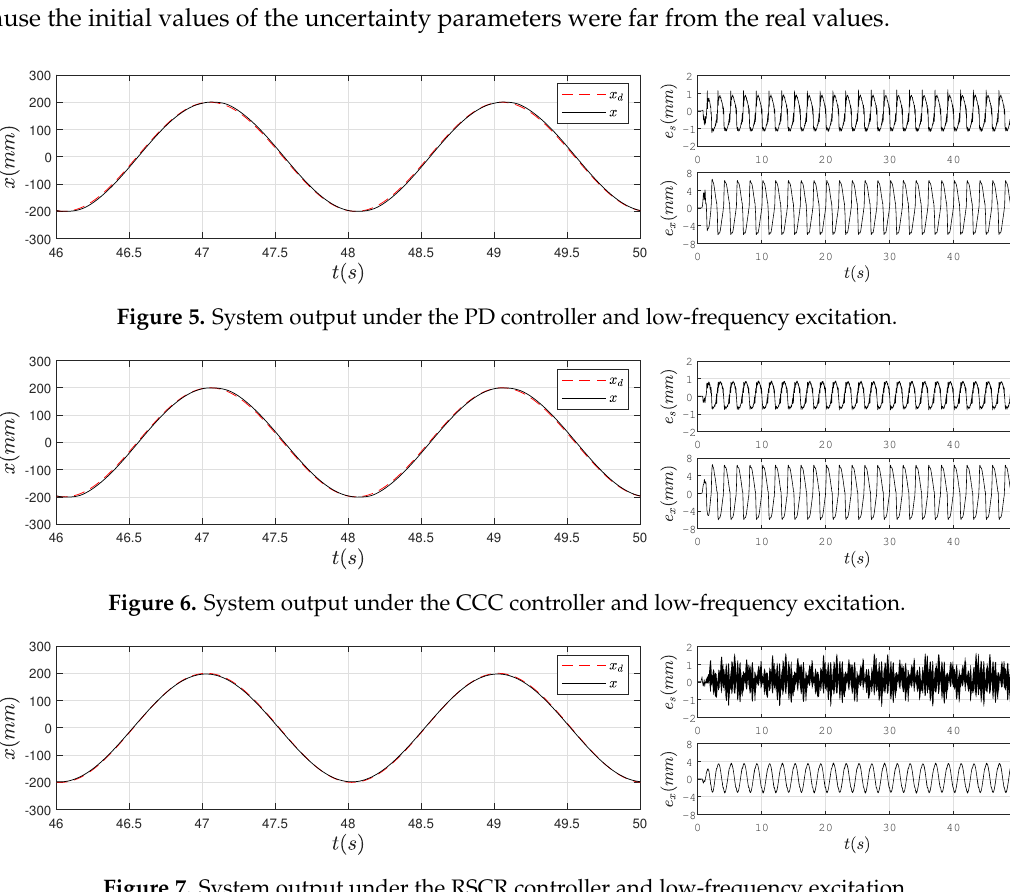
Figure 7. System output under the RSCR controller and low-frequency